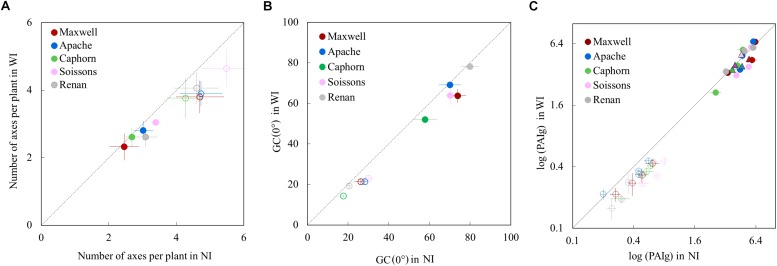
The number of axes per plant (A), the vertical ground cover GC(0°) (B), and the green plant area index PAIg (C), in WI treatments vs. NI treatments. Each color is associated with a cultivar, as indicated in the legend. Error bars represent the 95% confidence intervals of mean estimates and the dotted line represents the line 1:1. In (A), each symbol represents the mean value of the number of axes measured for 20–30 plants per treatment. Empty symbols are for end of tillering (∼870°Cd) and full symbols are for flowering. In (B), each symbol shows the mean value of GC(0) from analyzing six photographs covering each an area of 0.73 m2. Empty symbols represent measurements at 682°Cd (LS = 5.6) and full symbols represent measurements at 1565°Cd (after flag ligulation). In (C), circles show the PAIg estimated from oblique photographs: estimates at early stages are shown with empty circles (520°Cd, 532°Cd, 657°Cd, and 683°Cd) and estimates at later stages are shown with full circles (952°Cd, 1222°Cd, and 1555°Cd). Each circle shows the mean of values calculated from analyzing three photographs covering each area of 2.03 m2. Triangles represent the PAIg measured at flowering (1575°Cd) from scans of leaves and stems.